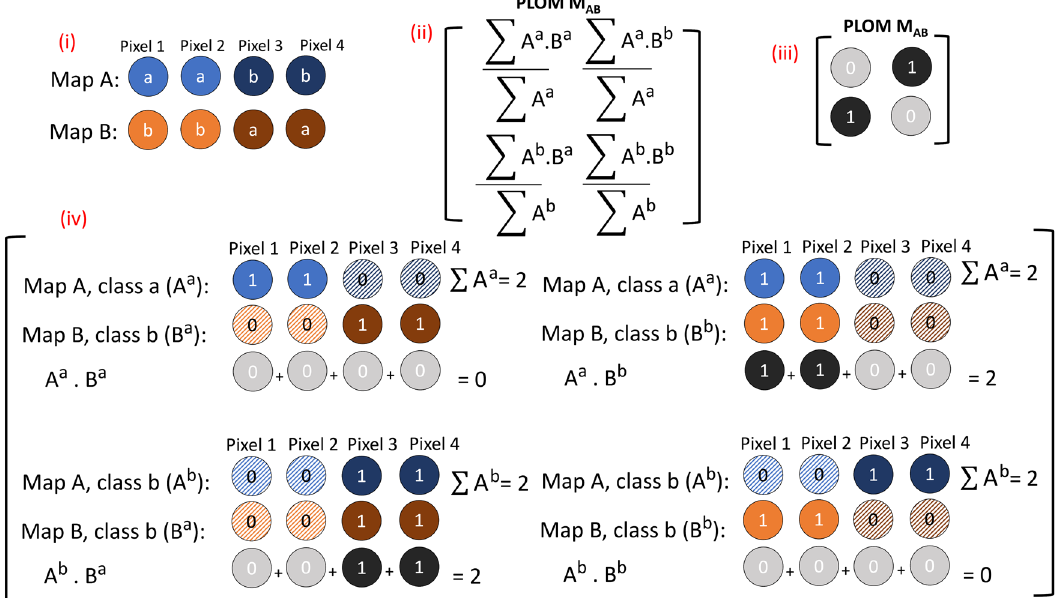
Fig. 8 An example of the procedure for generating the proportional label overlap matrix for two 4x1 pixel maps, Map A and Map B (denoted by the red (i), to avoid confusion). Each map contains two arbitrarily assigned labels, a and b. The matrix marked (ii) has each element populated by the speci fi c calculation required to evaluate that element. The values resultant from these calculations are given in (iii). The intermediate steps for evaluating (iii) are given in (iv), with each element showing: the binary masks for the respective labels of A and B; the total number of the speci fi ed A label; and the summation that yields the dot product of the binary